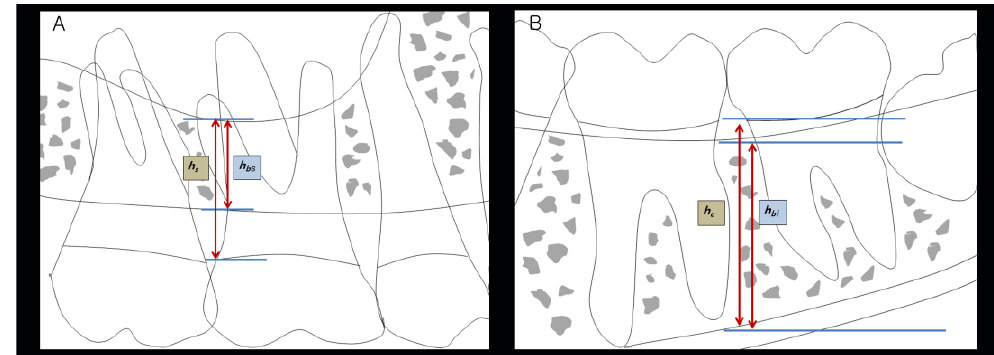
Figure 1. Measurement of bone height. ( A ) Maxilla: (h ′ s − h ′ bs) − (hs − hbs) (hs = CEJ to floor of the sinus; hbs = top of the alveolar bone level to floor of the sinus); ( B ) Mandible: (h ′ c − h ′ bi) − (hc − hbi) (hc = CEJ to inferior alveolar canal; hbi = top of the alveolar bone level to the roof of the inferior alveolar canal; h= preoperative length; h’= postoperative length ). CEJ: cementoenamel junction.